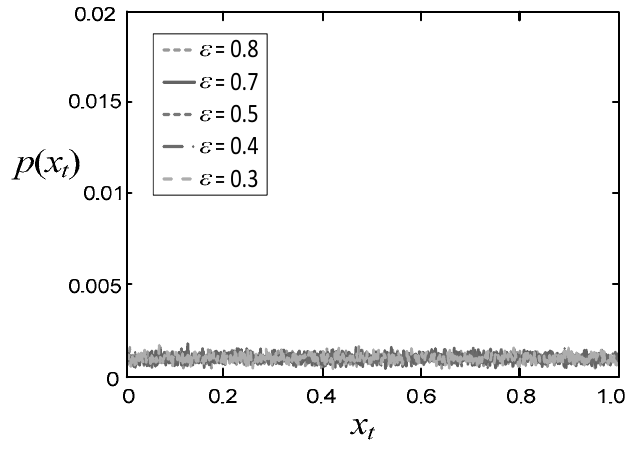
Figure 11. The simulation results of the improved CML based on the tent map.